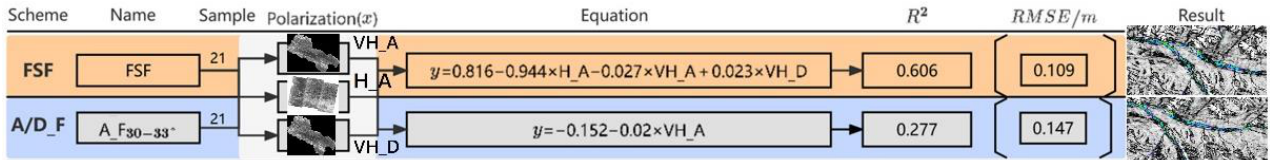
Figure 6. Linear and nonlinear fitting equations for the Babao River. Orange, yellow, and blue indicate the methods with better accuracy for each scheme. Two-tailed, 95% confidence interval. * represents a significant correlation at the 0.05 level. ** represents a significant correlation at the 0.01 level. Entropy is denoted H , and anisotropy is denoted A . Rectangular boxes indicate simulations using H , rounded boxes indicate simulations using VH, and pointed boxes indicate simulations using VV. The polarization methods of the FSF and TSF schemes use images that are ascending orbits close to the acquisition date, while that of the A/D_F scheme divides images according to the ascending orbit, descending orbit, and incidence angle. The thickness of river ice in April in the Babao River is 0.